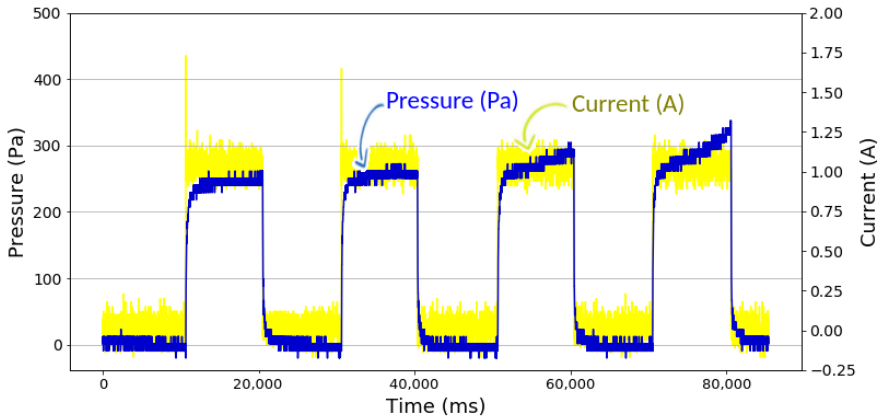
Figure 8. Experiment results of MRFs pressure at an input current of 1.00